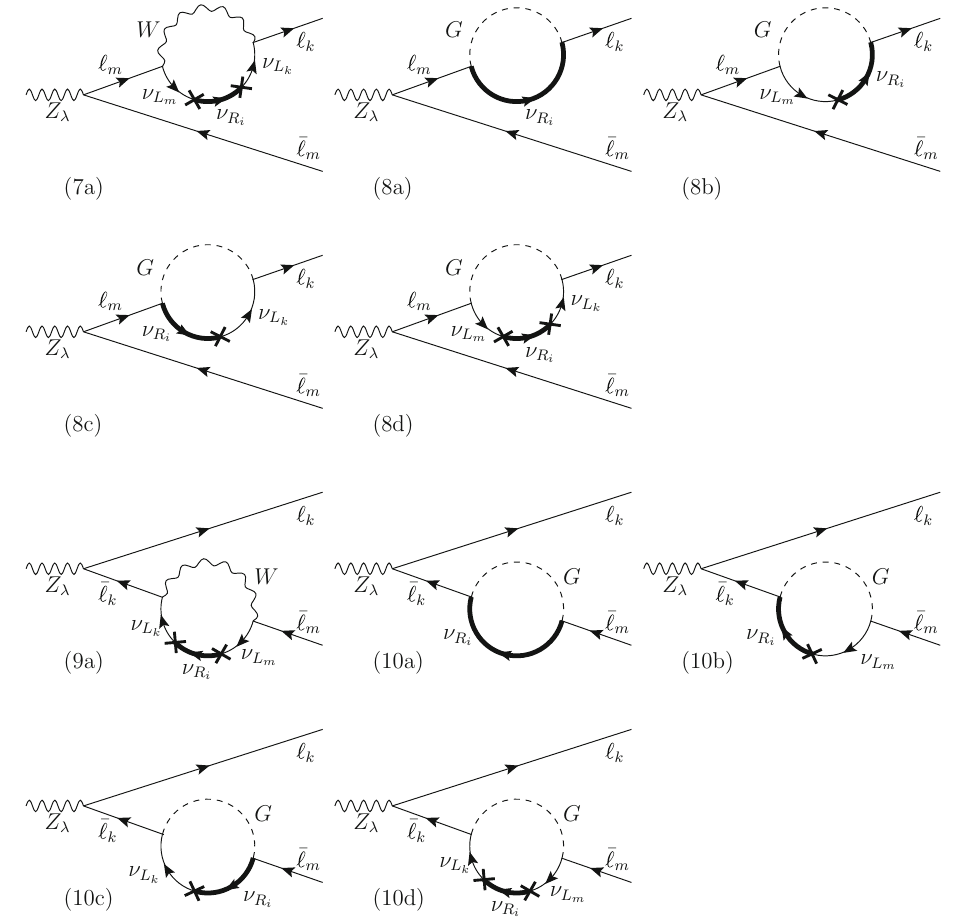
Fig. 3 Relevant diagrams of O ( Y 2 ν ) in a covariant gauge corresponding to external leg corrections